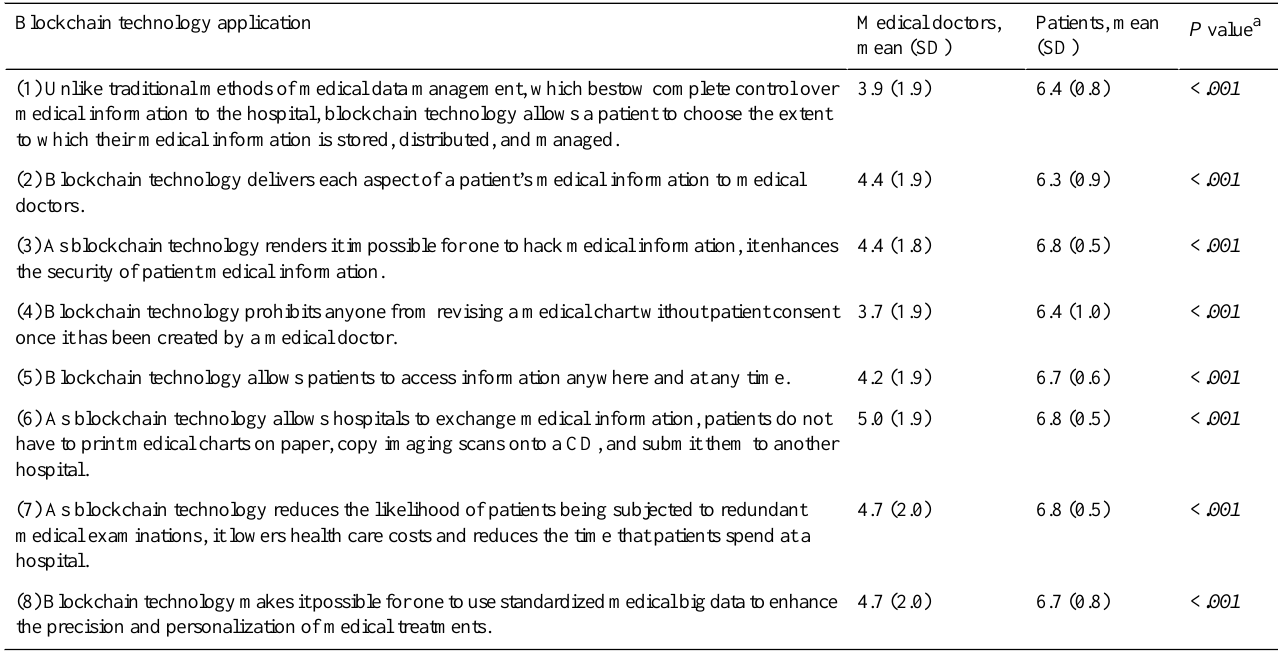
Table 3. Significance of the difference in attitudes toward the use of blockchain technology in the management of medical information between medical doctors and patients.